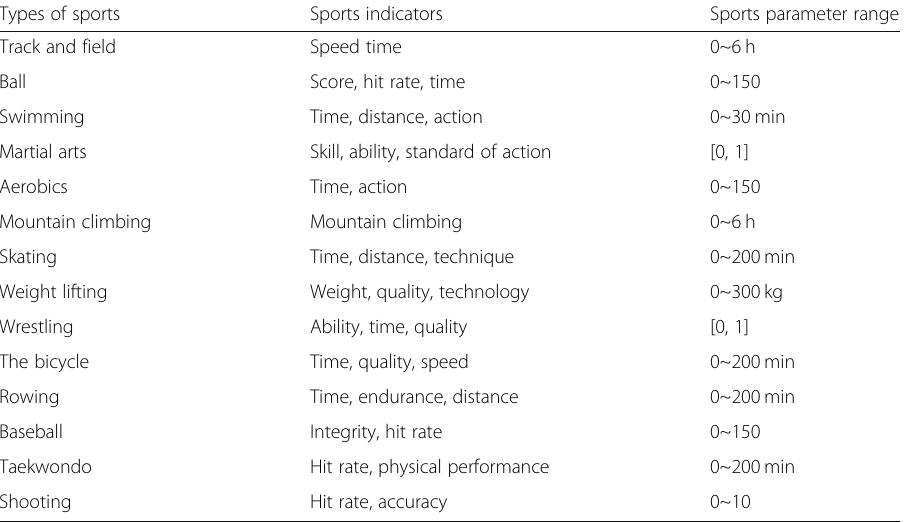
Table 2 Simulation parameters of index types Types of